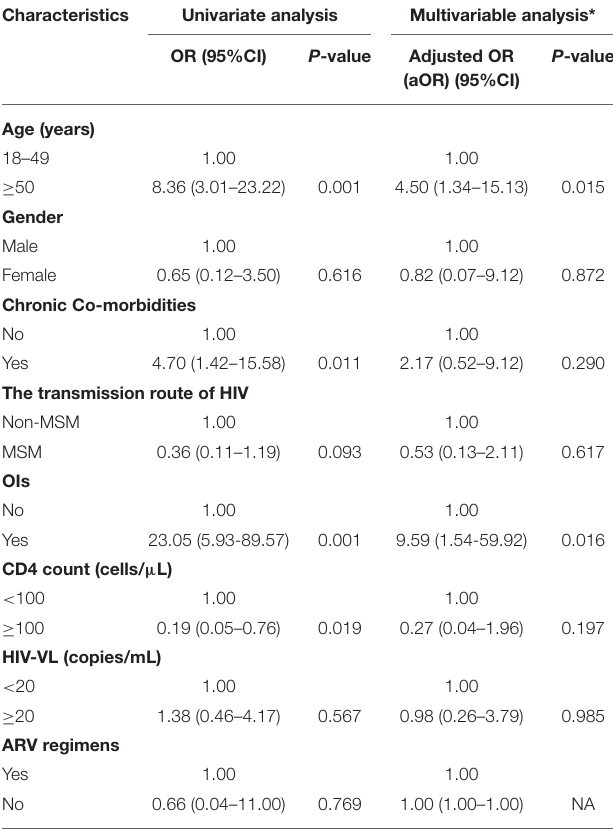
TABLE 4 | The risk factors of SARS-CoV-2 infection among PLWH from Wuchang district in Wuhan, China ( N = 857).